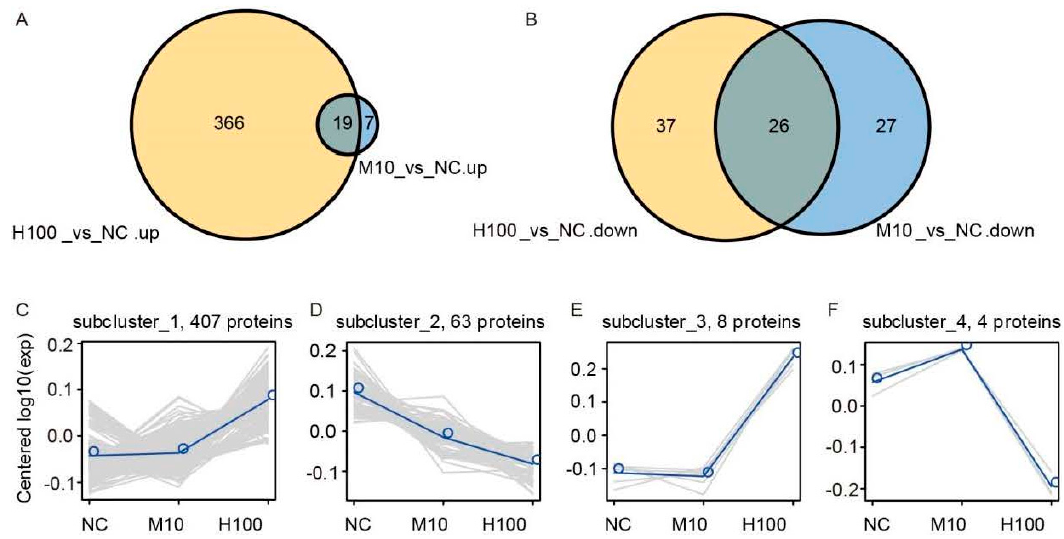
Figure 4. The expression of the 482 identified differentially phosphorylated proteins identified by iTRAQ. ( A ) Phosphorylated proteins up-regulated differentially by the presence of Cd 2+ ; ( B ) Phosphorylated proteins down-regulated differentially by the presence of Cd 2+ . The orange segments refer to proteins more abundant in the H100 treatment but not in the M10 treatment, and the blue ones vice versa; the gray segments refer to proteins differentially abundant in both Cd 2+ treatments; ( C – F ) Contrasting patterns of expression among the 482 differentially phosphorylated proteins: within each panel, the gray lines represent the abundance of individual phosphoproteins, and the light blue line represents the average pattern.